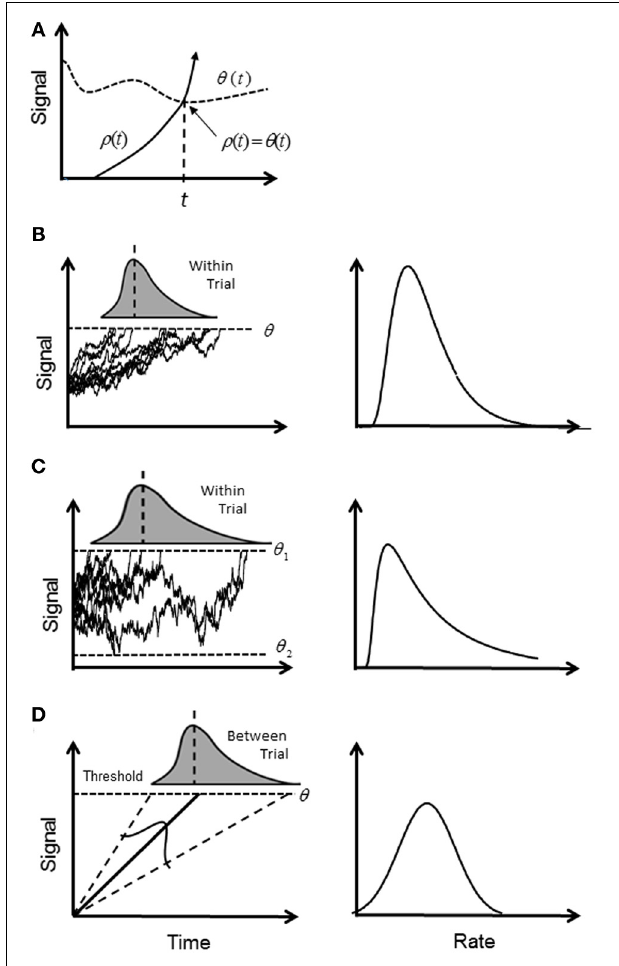
FIGURE 1 | Illustration of accumulator models: (A) general first-passage scheme where a triggered event occurs when a signal ρ ( t ) first crosses the trigger level θ ( t ). Note that crossing is a solution to the equation ρ ( t ) = θ ( t ); (B) in the diffusion model ρ ( t ) increases stochastically and triggers a response when it reaches a constant θ ( t ), or “threshold.” The signal is assumed to be a Wiener process, and the first passage time is a within-trial random variable (shaded curve) with an inverse Gaussian distribution. In the rate domain (right column) the rate distribution remains positively skewed; (C) the diffusion model for two boundaries, where boundary θ 1 ( t ) determines correct responses, and boundary θ 2 ( t ) determines error responses. In the rate domain, rate of correct responses remains positively skewed. (D) In the deterministic model, ρ ( t ) increases linearly and deterministically until the threshold is reached. It is assumed that the slope of rise is a between-trial Normal random variable and gives rise to a reciprocal Normal distribution. In the rate domain, rate is distributed with a truncated Normal